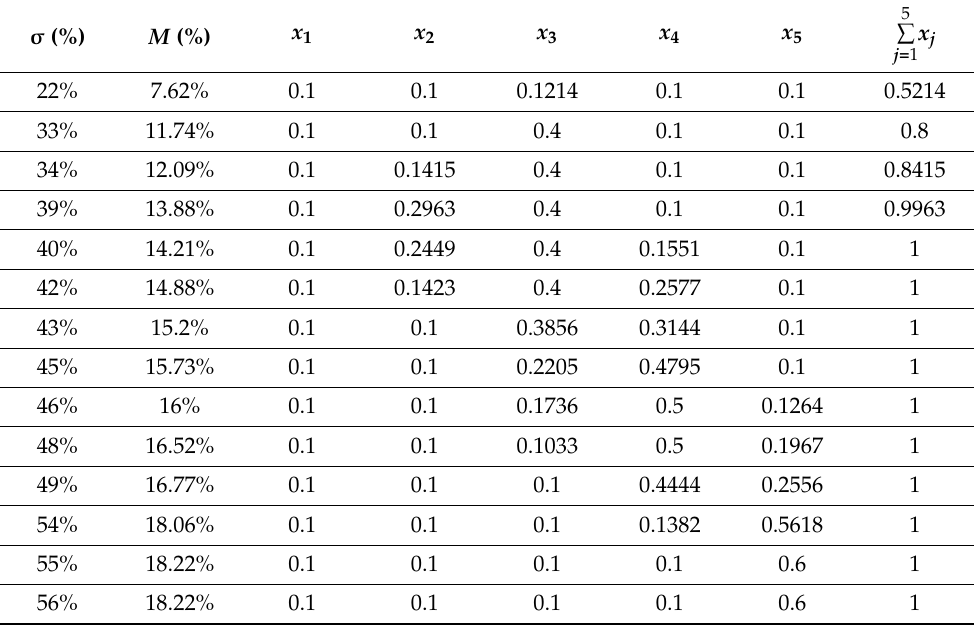
Table 1. The possibilistic efficient portfolios with recession stage by Chen and Tsaur’ model.